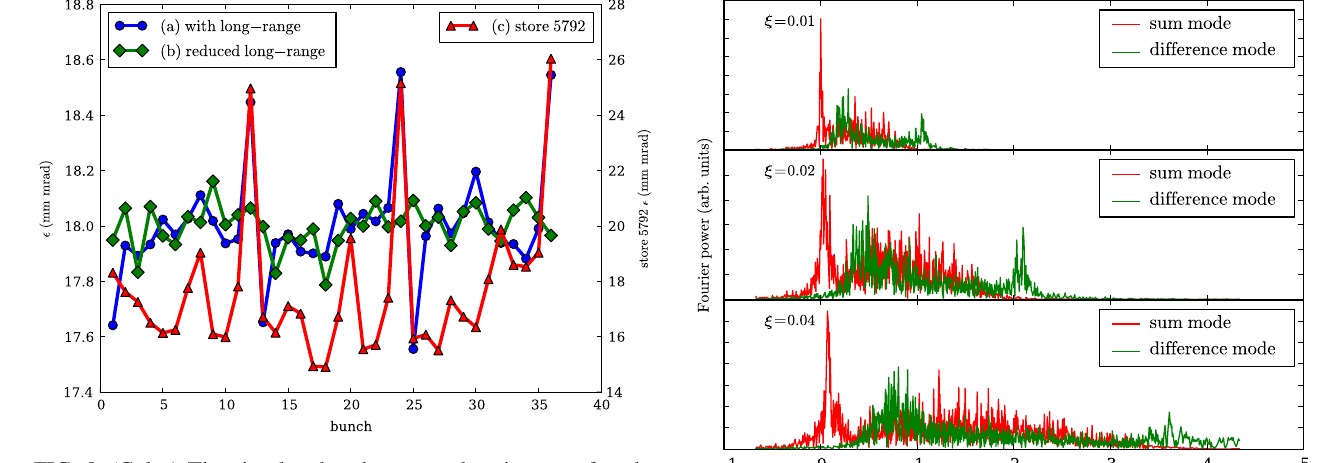
FIG. 8. (Color) The simulated and measured emittance of each Tevatron proton bunch after running with 36 proton and 36 antiproton bunches. Curves (a) and (b) which show the emittance after 50 000 simulated turns are read with the left vertical axis. Curve (a) results from a simulation with the nominal beam spacing at the long-range IPs. Curve (b) results from a simulation with the hypothetical condition where the beam separation at the long-range IPs is 100 times normal, suppressing the effect of those long-range IPs. Curve (c) is the measured emittance of bunches after 15 minutes of a particular store (#5792) of bunches in the Tevatron, and is read with the right vertical